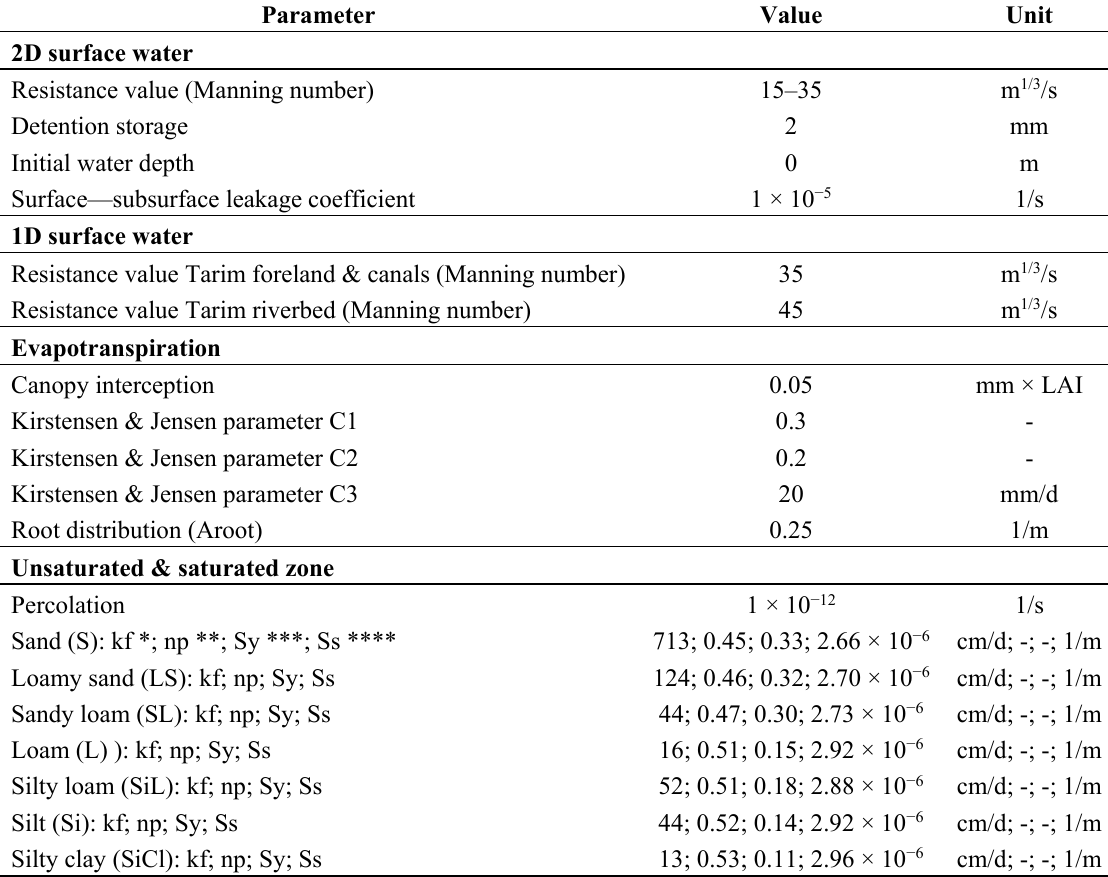
Figure 2. Schematic view of the MIKE SHE modules (DHI©, modified by Keilholz). Table 1. Parameter setup for the MIKE SHE